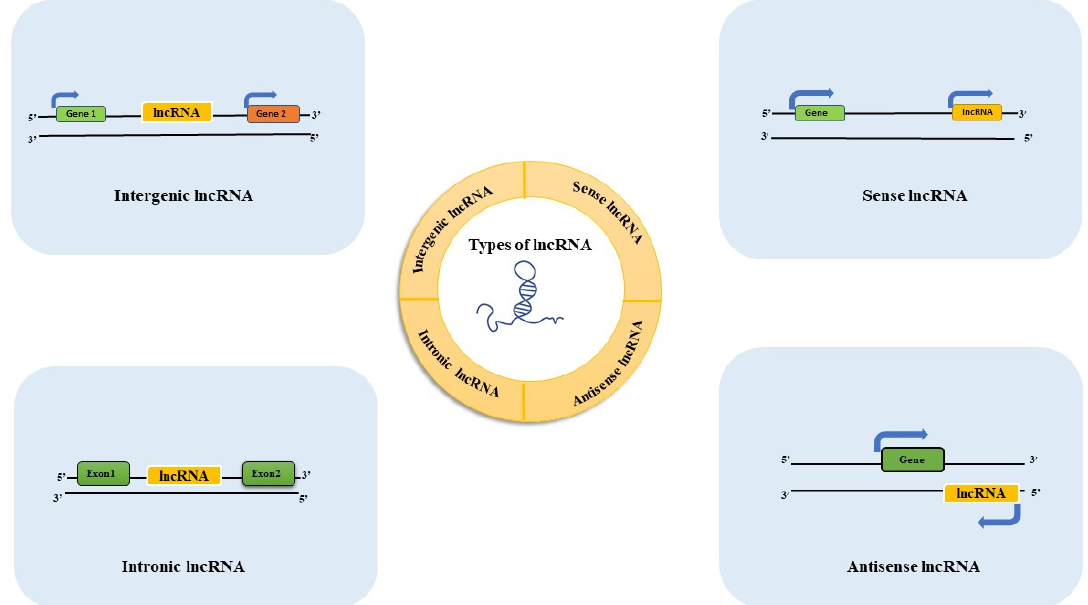
Figure 2. Classification of lncRNAs in the context of genomic locations. Intergenic LncRNAs are transcribed from the genomic region between two coding genes. Sense lncRNA are transcribed from the sense strand of protein-coding genes whereas antisense lncRNAs are transcribed from the opposite strand of coding genes. Intronic lncRNA are transcribed entirely from introns of protein-coding genes.